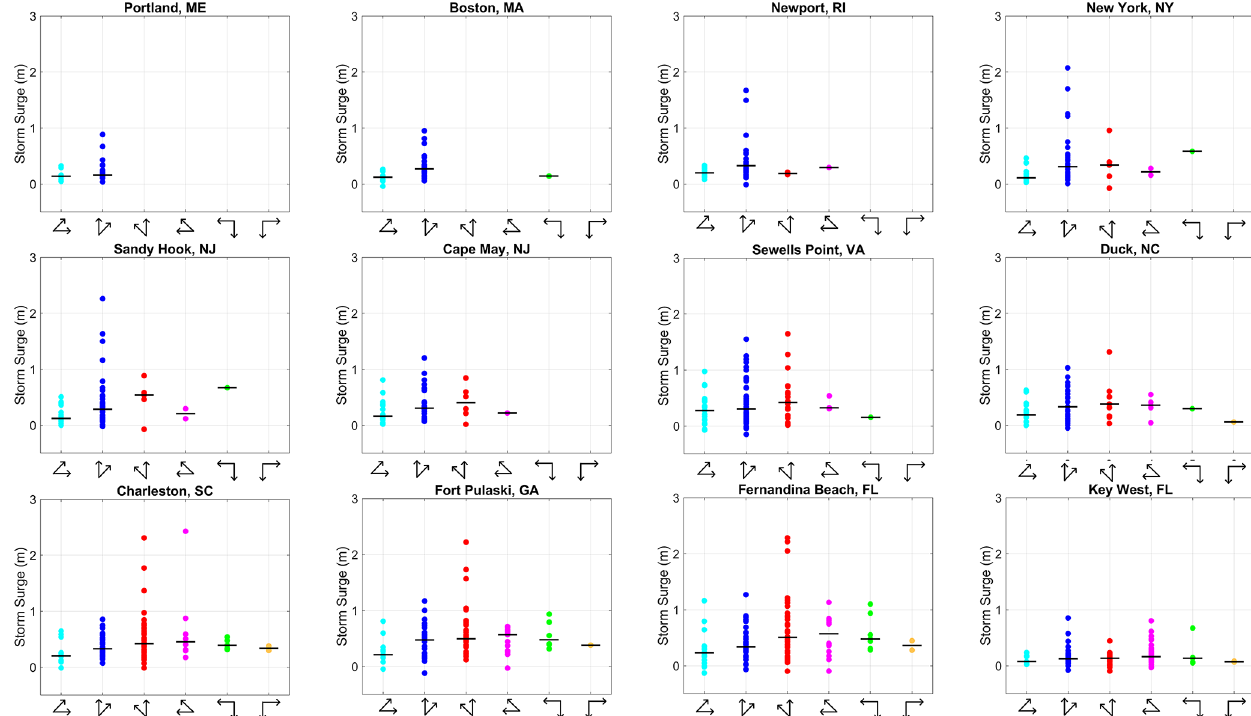
Figure 4. Storm surge (m) separated by track path angle. Arrows along the x axis indicate range of TC track movement, which is similar to track path angle key in Fig. 1. From left to right, arrows correspond to ENE (light blue), NNE (dark blue), NNW (red), WNW (magenta), SW (green), and SE (orange). The horizontal black line indicates the median value of storm surge for each group of track path